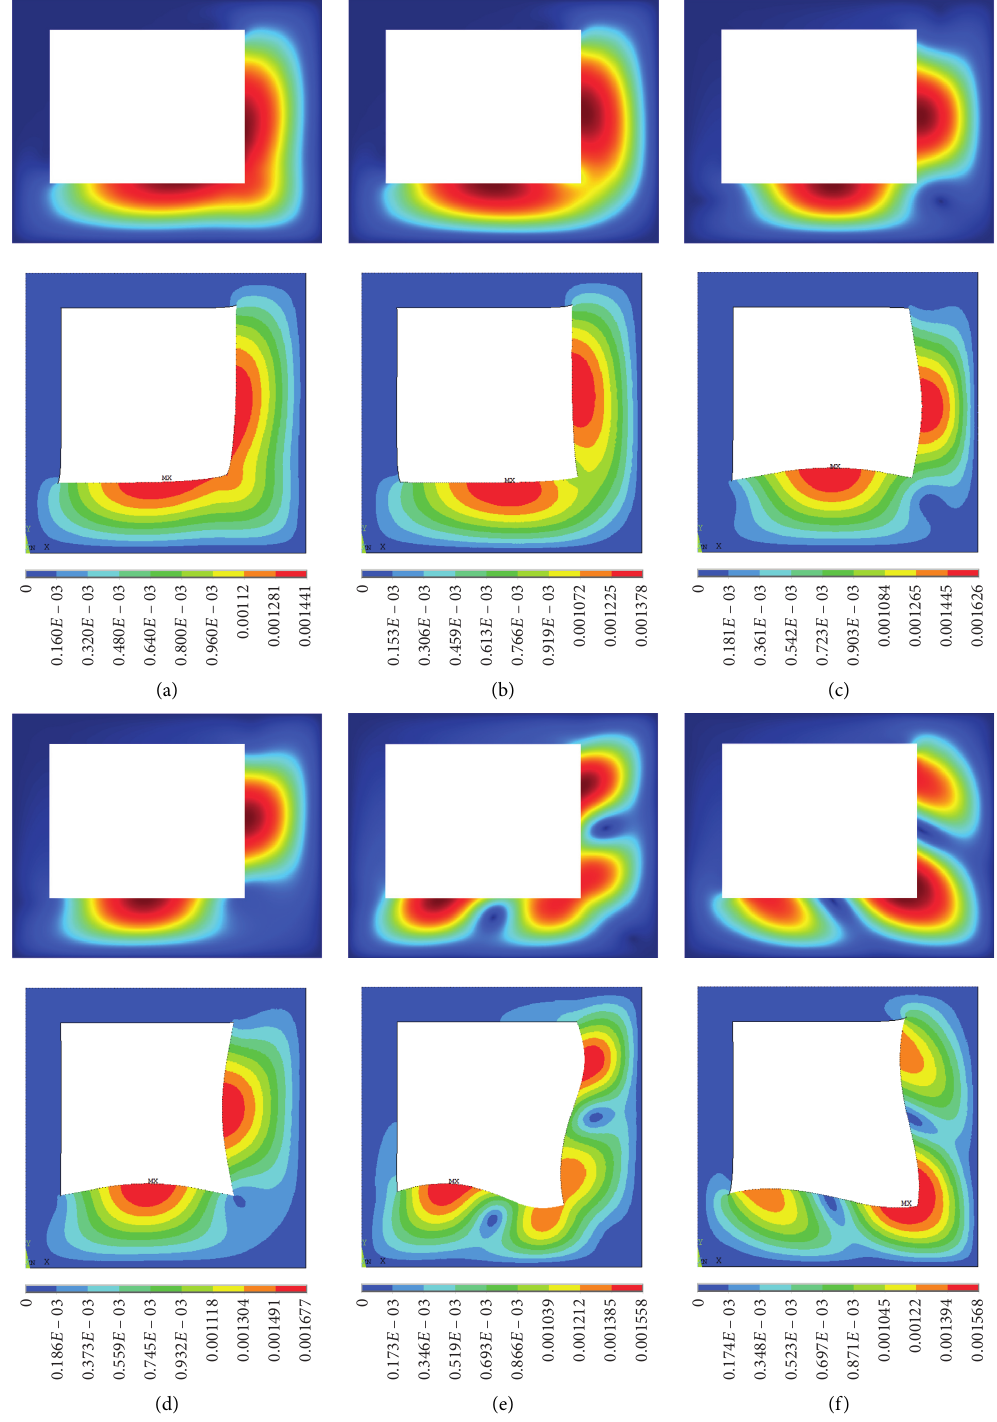
Figure 8: The first six mode shapes for the square plate with a cutout whose size is 25m × 25 m. (a) The first mode; (b) the second mode; (c) the third mode; (d) the fourth mode; (e) the fifth mode; (f) the sixth mode. Upper: the present results; lower: the ANSYS